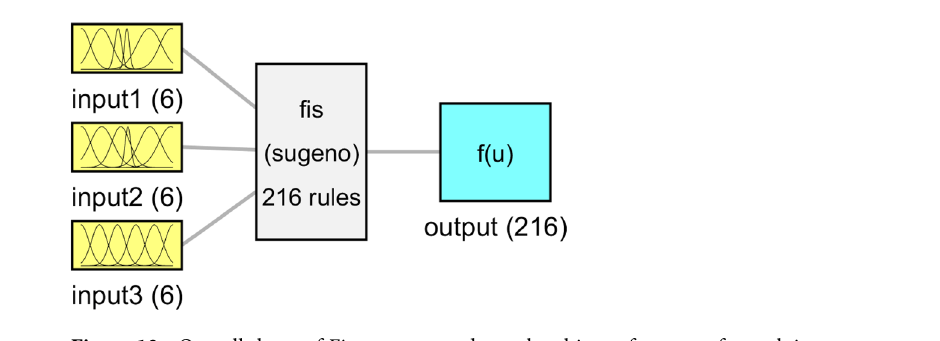
Figure 13. Overall shape of Fis structure and membership performance for each input parameter with six membership